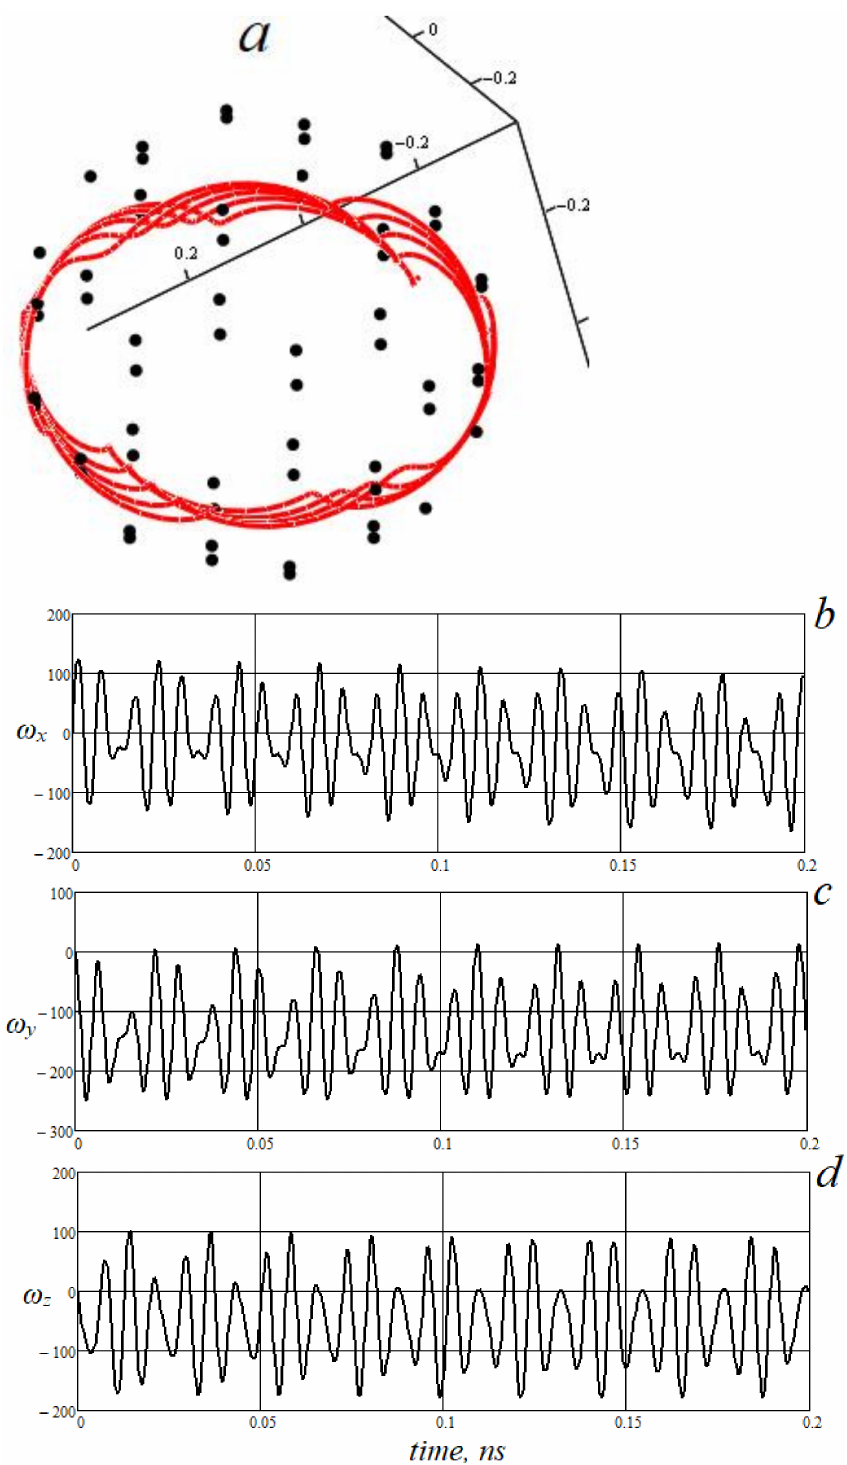
Figure 4. ( a ) Fullerene point trajectory; ( b ) x -projection of fullerene rotation frequency; ( c ) y -projection of fullerene rotation frequency; ( d ) z -projection of fullerene rotation frequency. Figure 4 refer to the quasi-plane fullerene rotation in a rotating field f = 1000